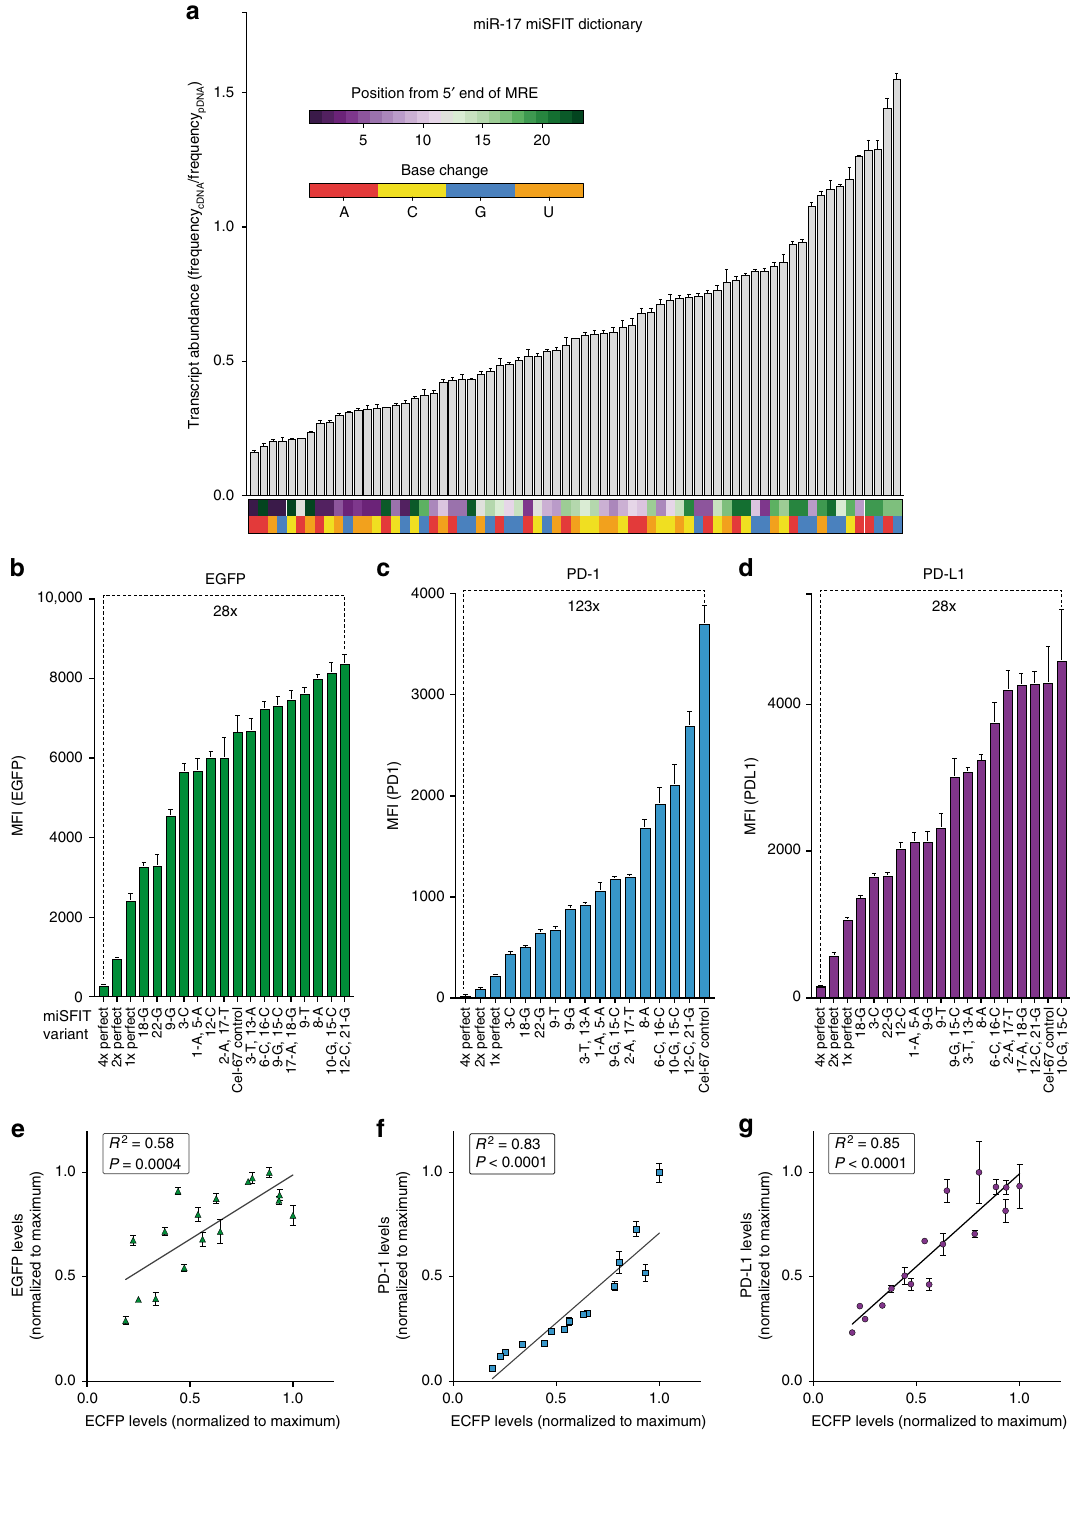
NATURE COMMUNICATIONS| (2019) 10:2622